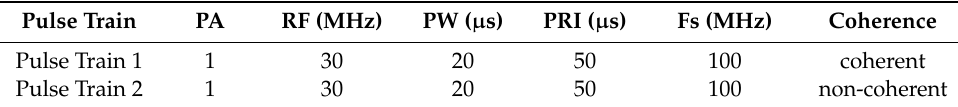
Table 1. Parameters of simulation signals.